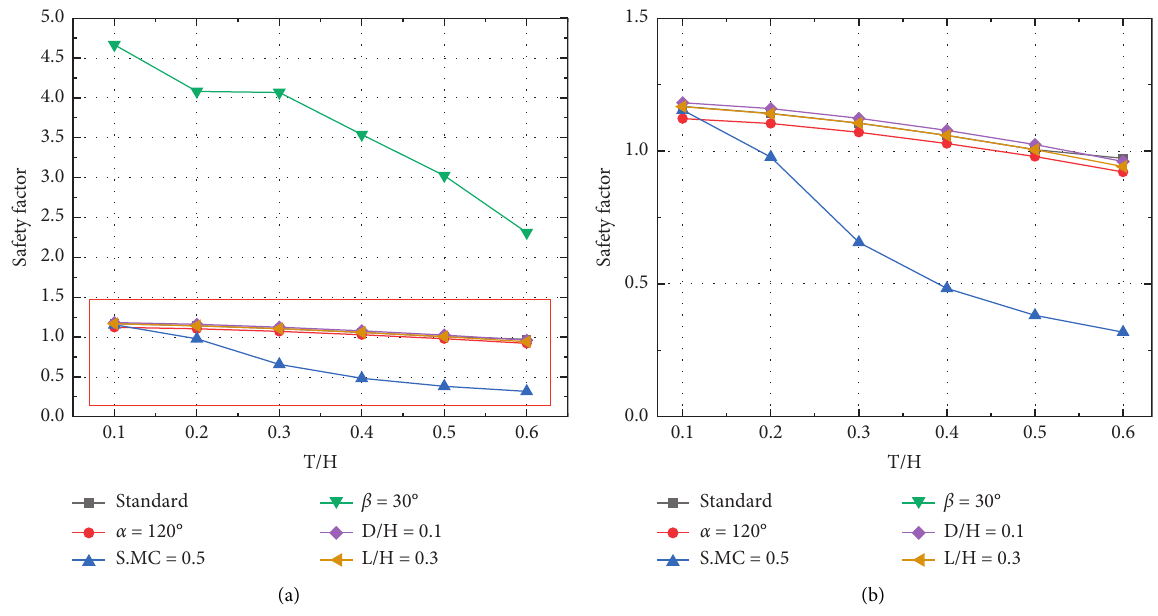
Figure 11: The influence of the thickness of the top layer on slope stability. (a) Calculation results. (b) Partial calculation